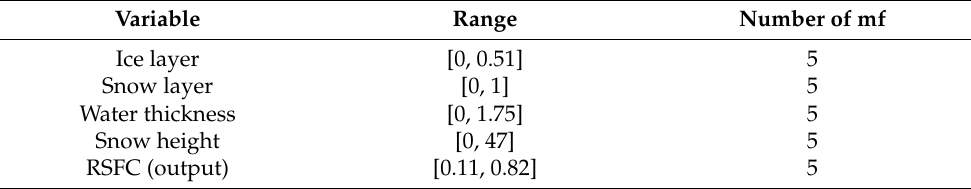
Table 6. Parameters (Mean and Std values) of each Gaussian mf (cluster) for inputs.